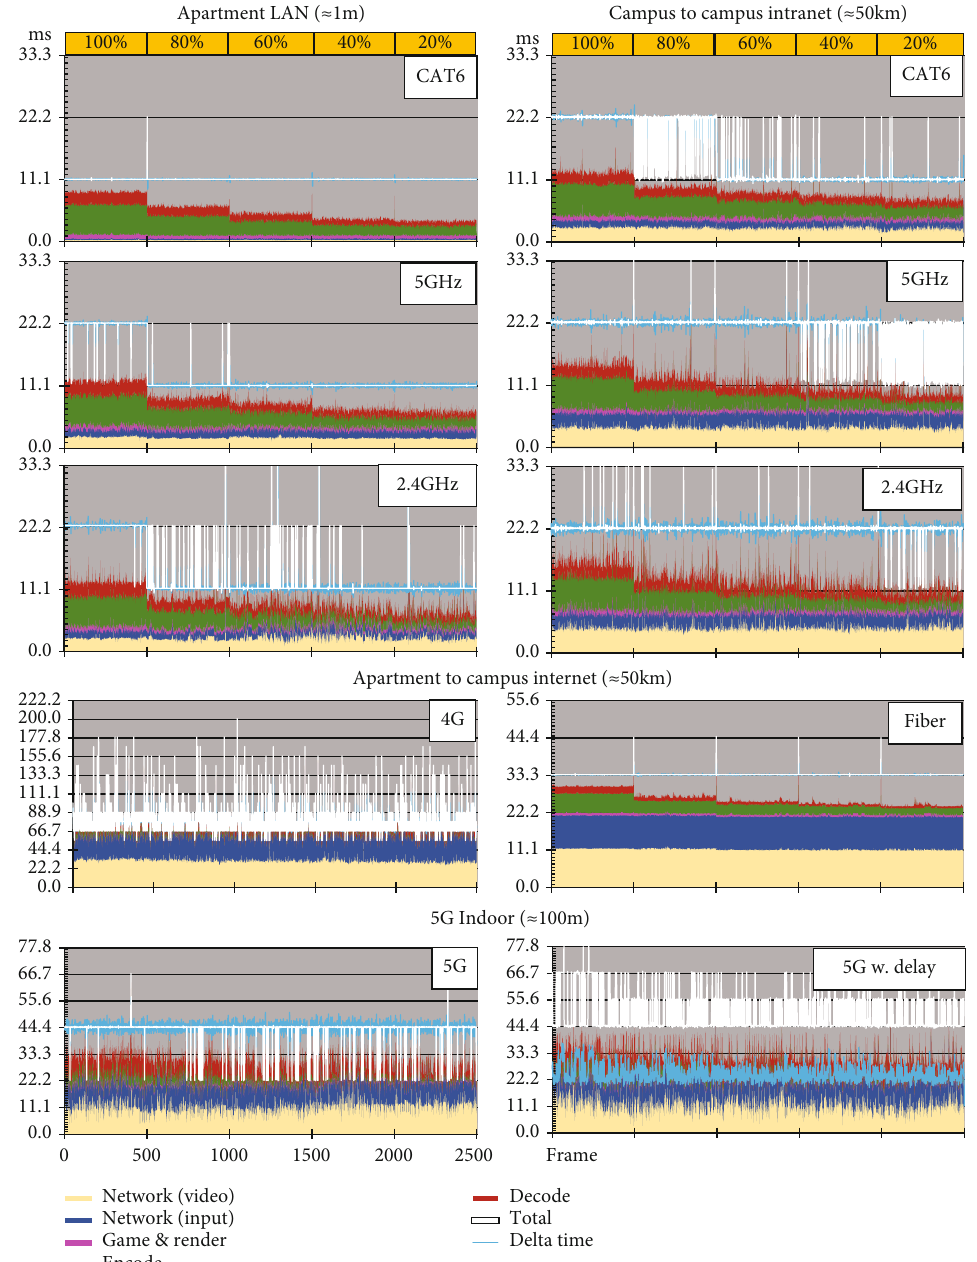
Figure 3: Examples of time consumption of the tasks performed each frame in the resolution experiments. Resolution was reduced one level at each 500-frame interval, see yellow bars and x -axis markers. “ Total ” shows the total time consumption in software of each frame from the client perspective; “ delta time ” shows time consumed between presenting two frames. The two overlap where there is no delay